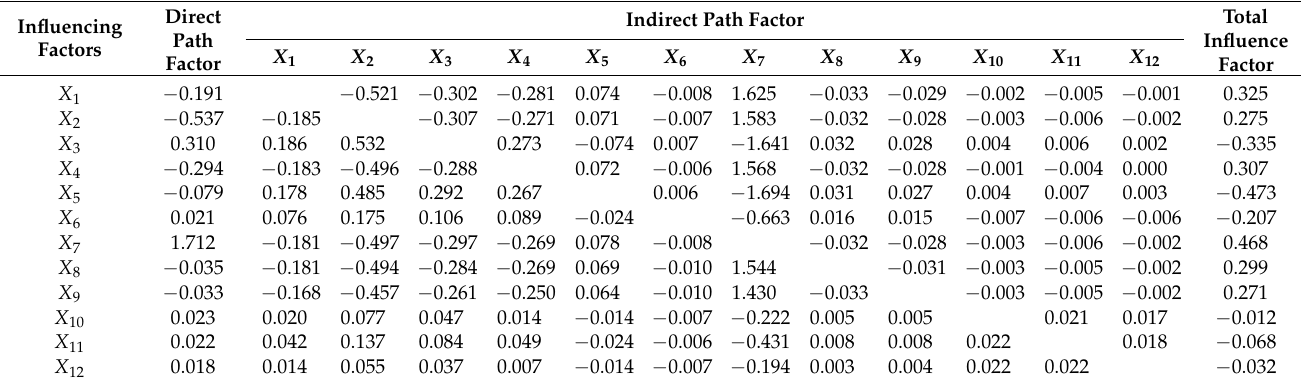
Table 4. Analysis results of influencing factors of temporal variation of AWF grey in the Yellow River